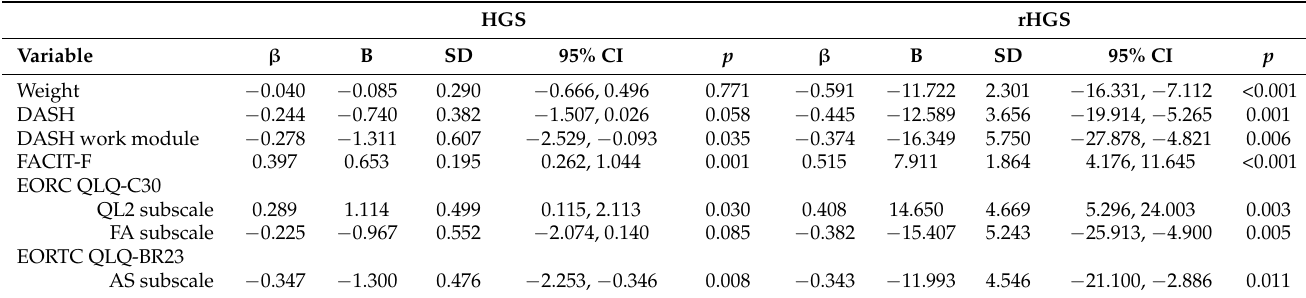
Table 3. Linear regression analysis assessing the association between HGS and rHGS to shoulder–arm disabilities, fatigue and HRQoL, controlling for the potential confounding effects of age, BMI and time elapsed since diagnosis. HGS